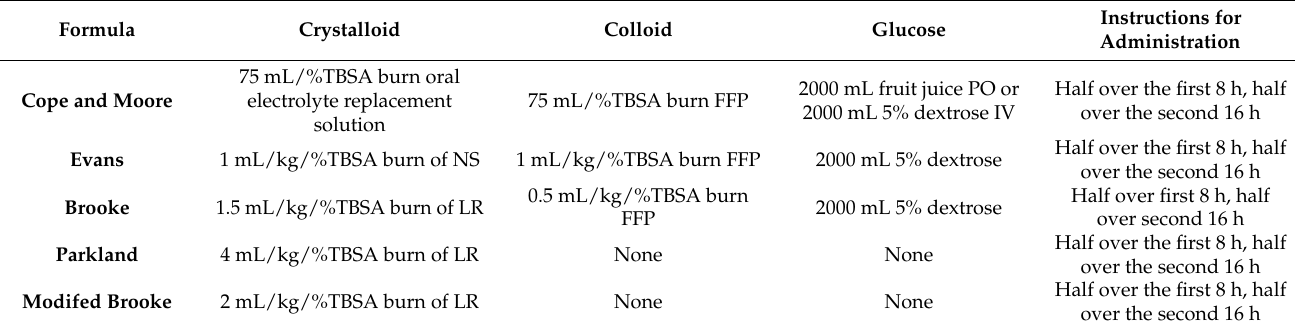
Table 1. Summary of Adult Formulas for burn fluid replacement